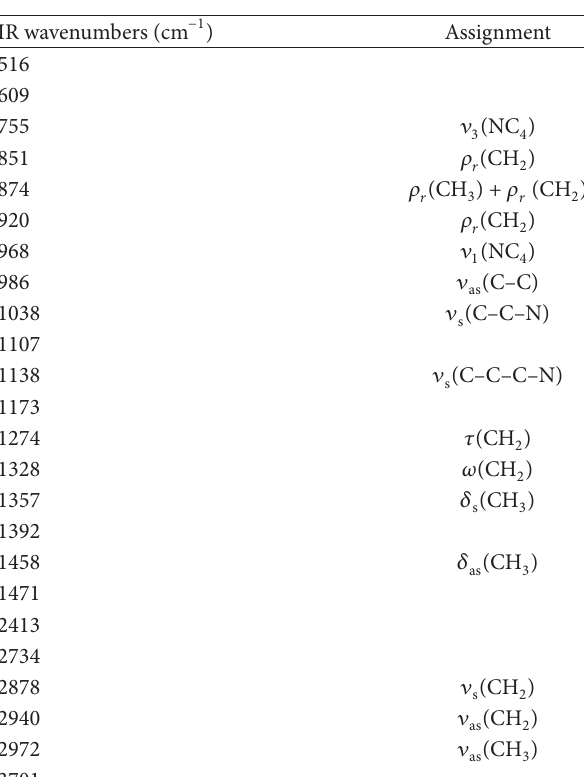
T 3: Observed IR frequencies (in cm